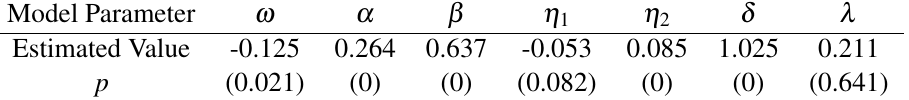
Table 2 The Estimation Results of the QR-GARCH Model of the HS300 Return